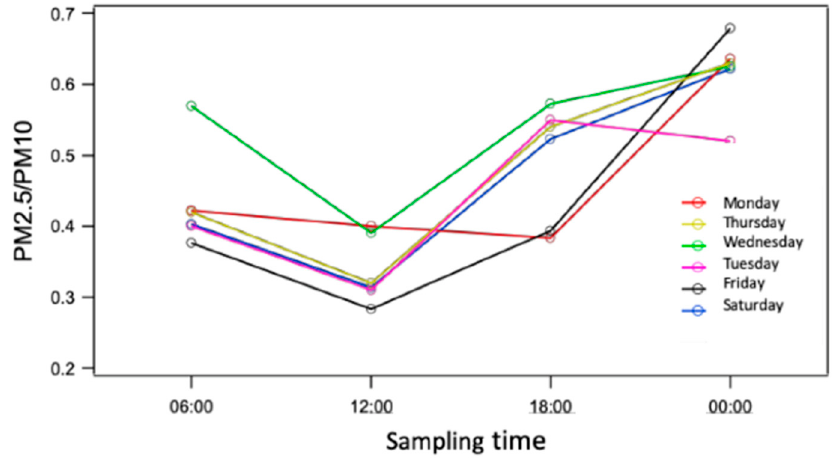
Figure 5. PM 2.5 / PM 10 concentration ratio during all sampling intervals for working days of the first week of